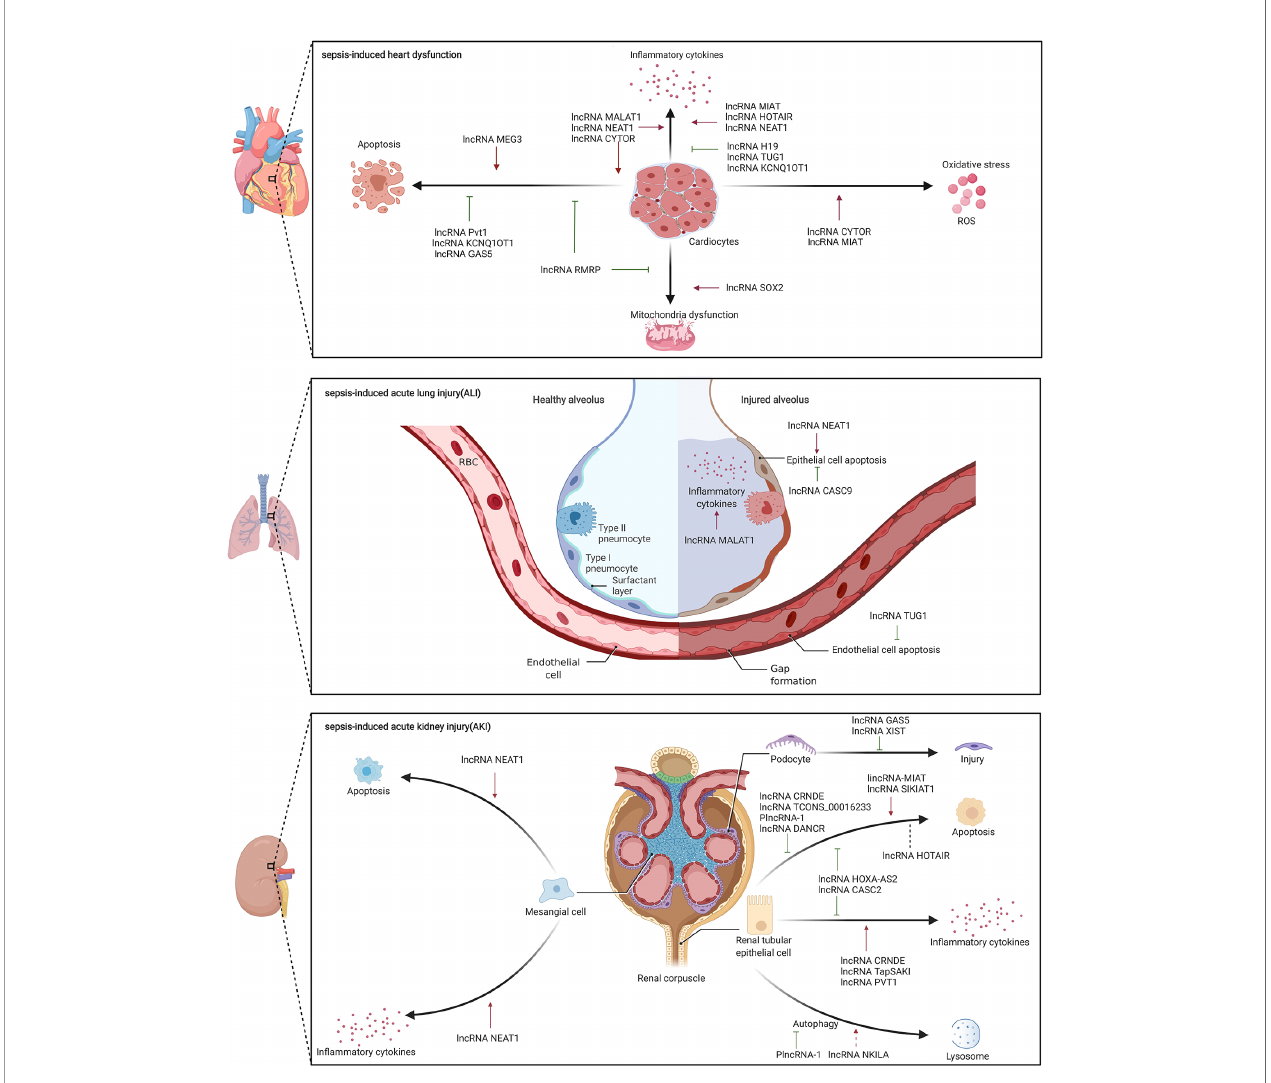
FIGURE 3 | The role of lncRNA in sepsis-induced organ